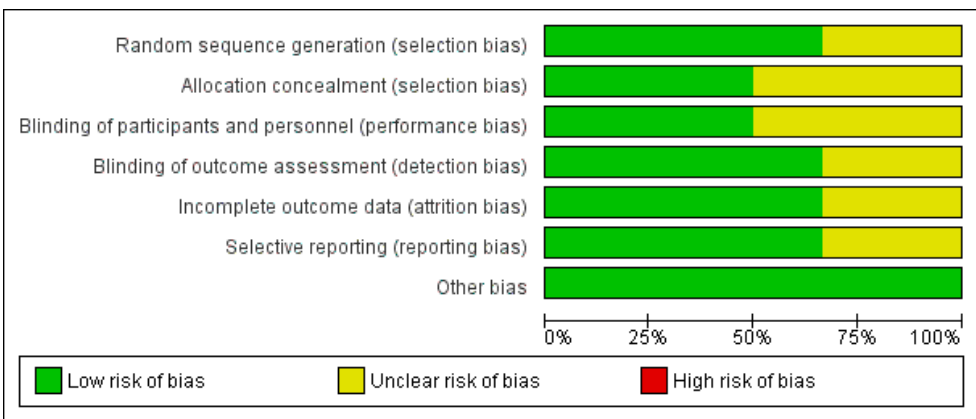
Figure 5. Risk of bias graph assessed for each criterion.